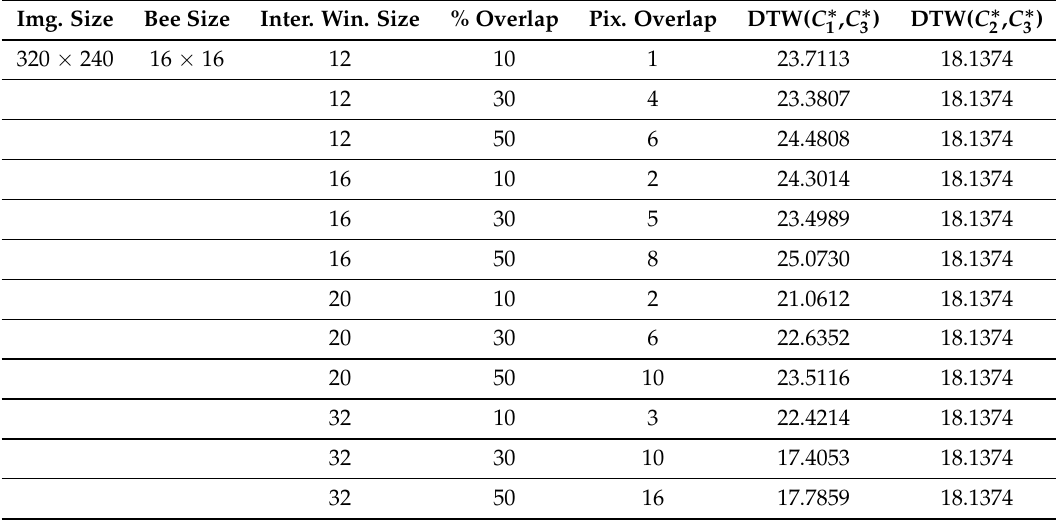
is DPIV; C ∗ is MOG2/VGG16; 2 1